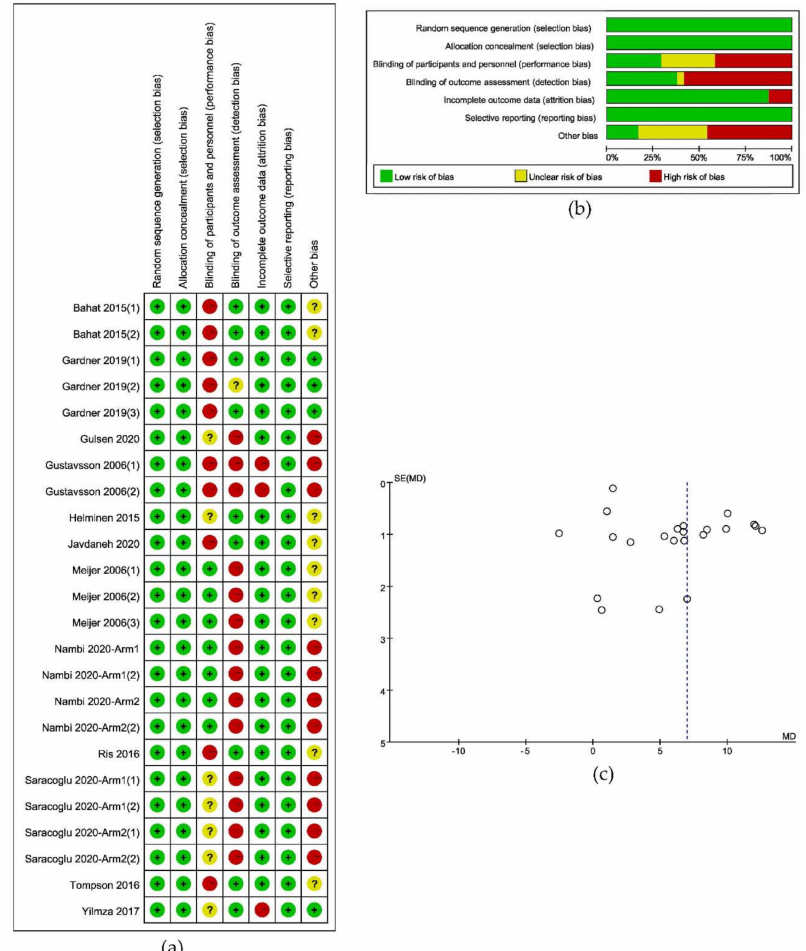
Figure 2. Results of risk of bias analysis: ( a ) Risk of bias summary; ( b ) Graph of risk of bias; ( c ) Funnel plot of included